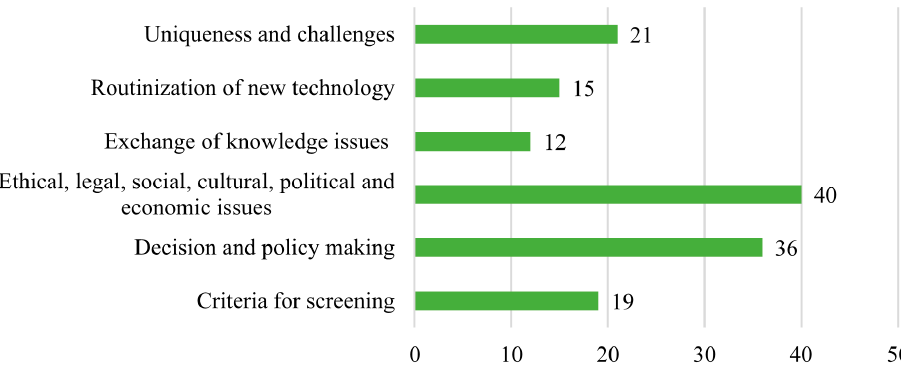
Figure 3. Coding families.